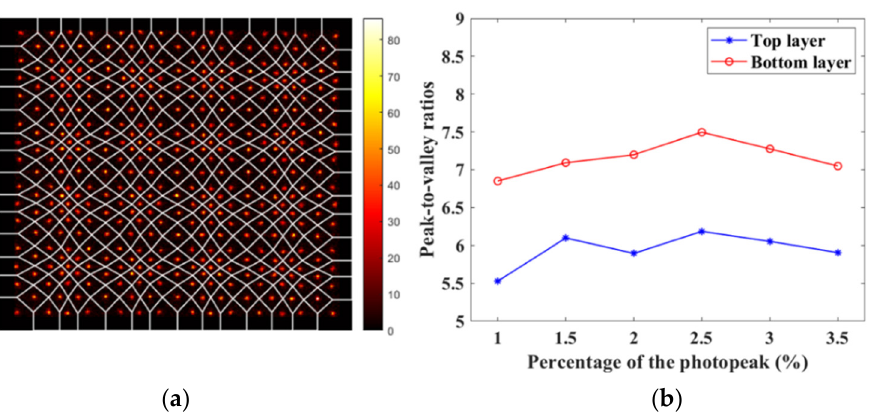
Figure 8. ( a ) Classification of the spots for the top and bottom crystals in the flood histogram of the BaSO 4 array with a threshold value of 2.5% of the photopeak. ( b ) Plot of the peak-to-valley ratios versus the threshold value (percentage of the photopeak).